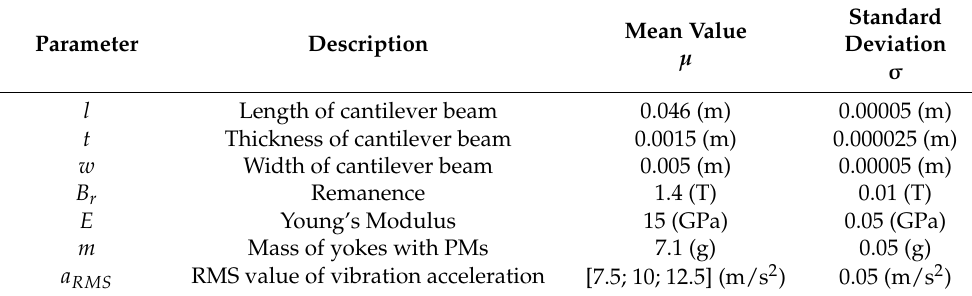
Table 2. Geometrical and material parameters of the system and vibration acceleration with stand- ard deviations.